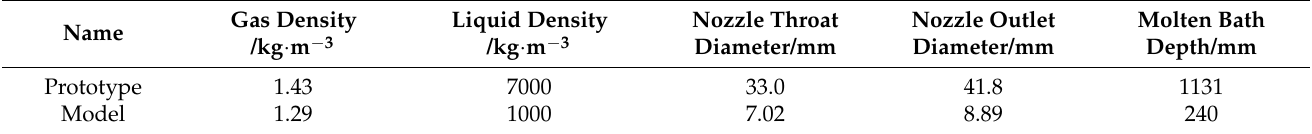
Table 2. Kinetic parameters related to the converter prototype and model.